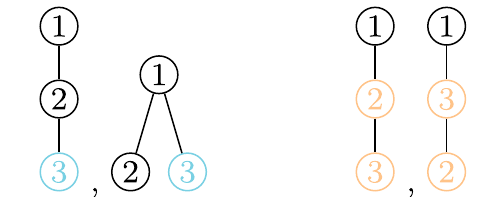
Fig. 1 Thetreegraphscontributethesoftandcollinearlimitinthefive- point. The left hand is the soft limit, and the right hand is the collinear